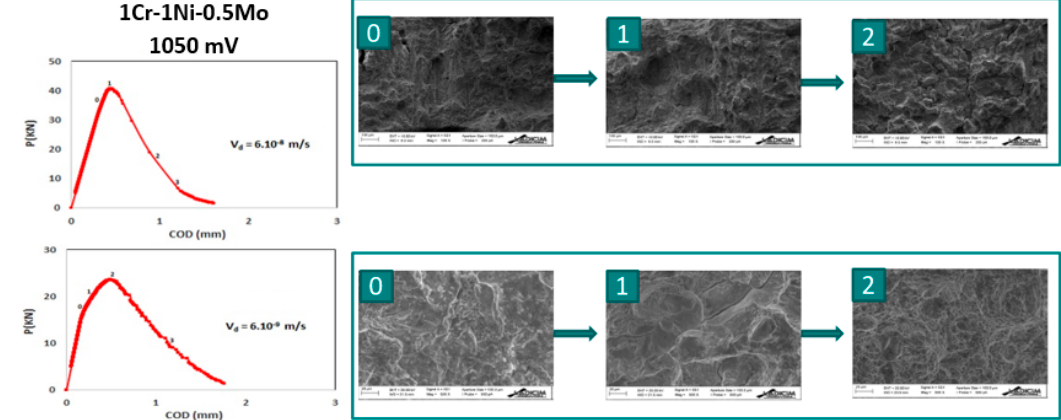
Figure 16. Fractographic images corresponding to different stages of P-COD register from the slow rate tests performed on 1Cr-1Ni-0.25Mn steel under 1050 mV CP environment at 6 × 10 − 8 and 6 × 10 − 9 m / s.